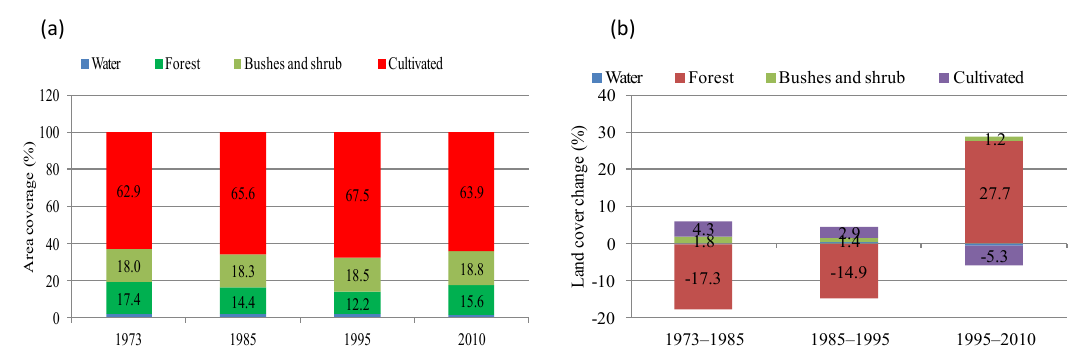
Figure 5. (a) LULC composition and (b) LULC change in the UBNRB during the period from 1973 to 2010.